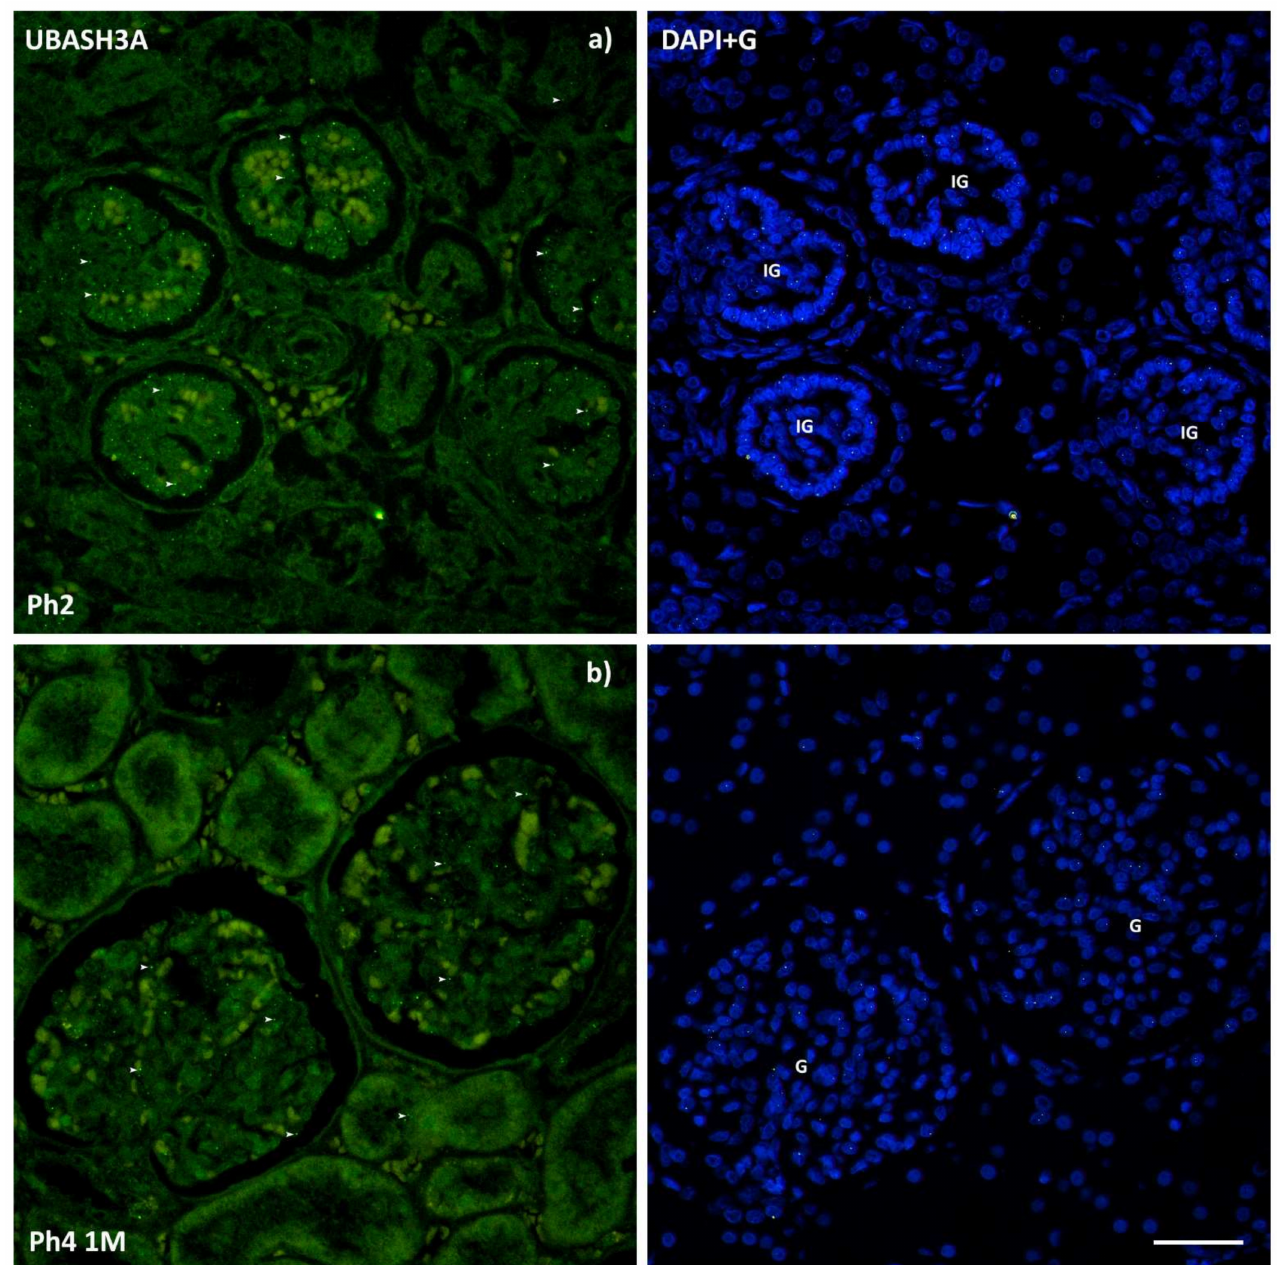
Figure 8. Immunofluorescence staining of human fetal ( a ) and postnatal ( b ) kidneys with the UBASH3A (green) marker and the isolated signal with DAPI nuclear staining. Expression of UBASH3A (arrows), glomeruli (G), and immature glomeruli (IG). Significant differences in immunoreactivity were found between fully differentiated ( b ) and immature ( a ) glomeruli. Images ( a , b ) were taken on magnification 40 × . Scale bar is 40 µ